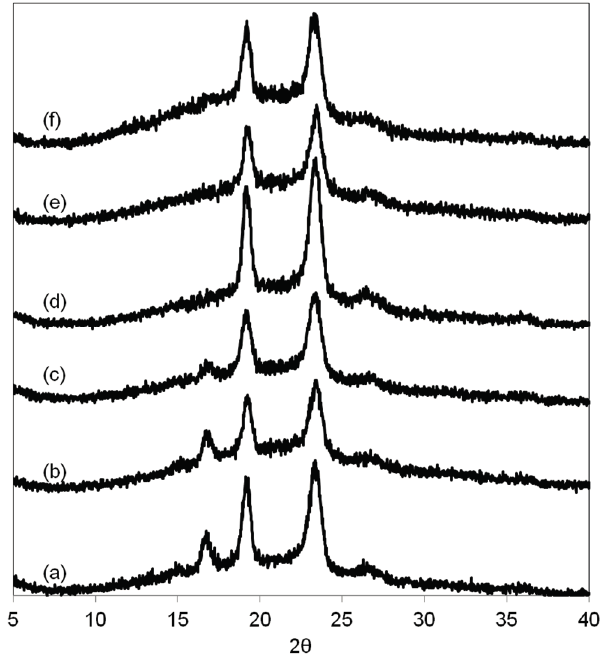
Figure 8. WAXD profile of the (a) LE(m)-1.35, (b) LE(m)-1.38, (c) LE(m)-1.53,